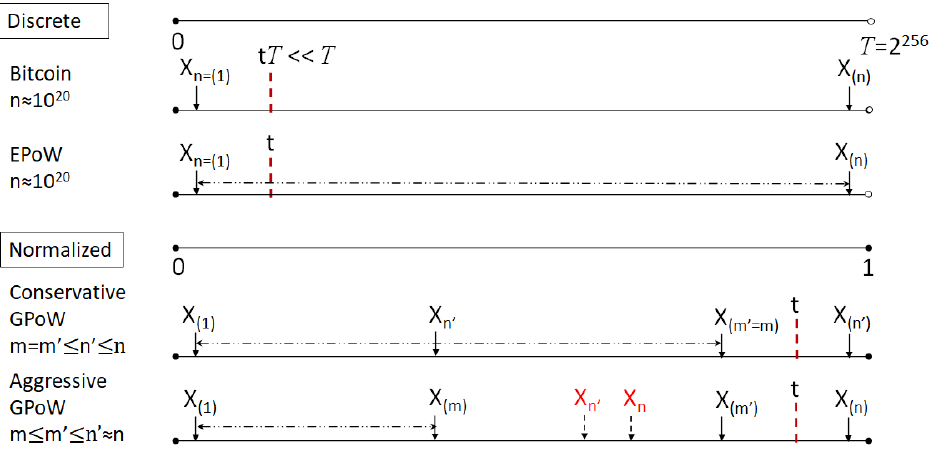
Figure 2. Mining by